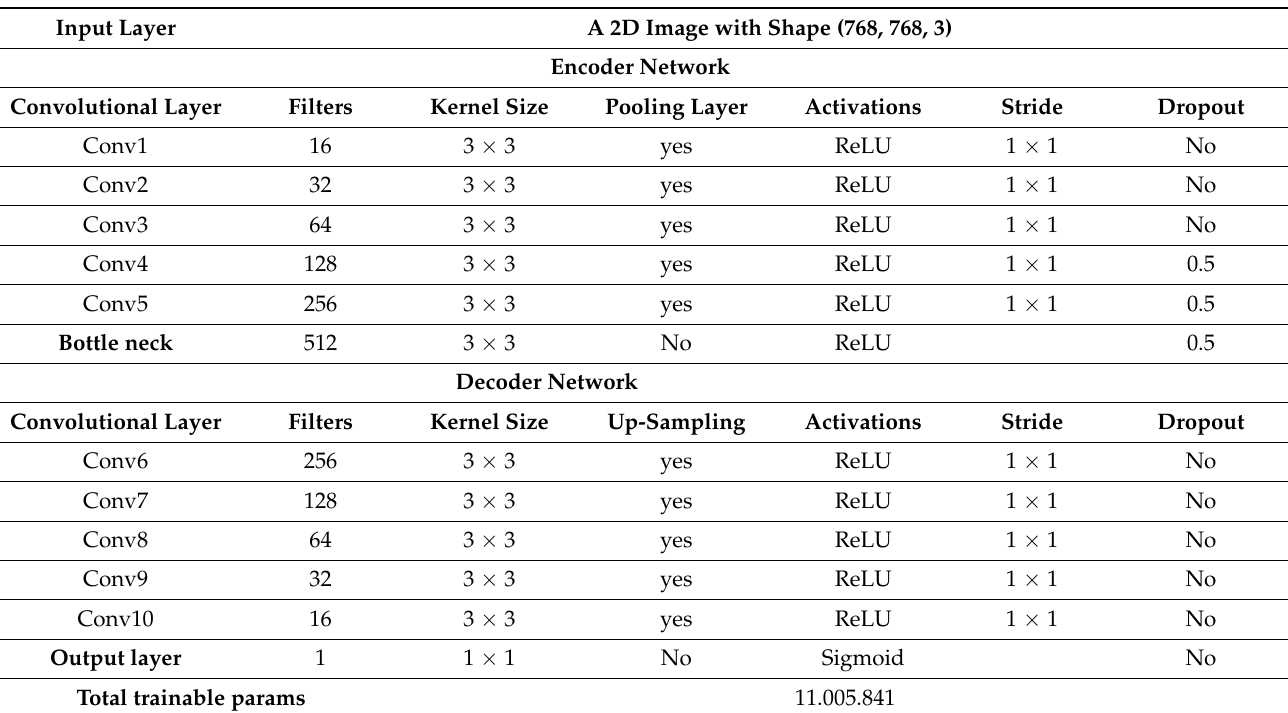
Table 4. Convolutional layers description for SegNet